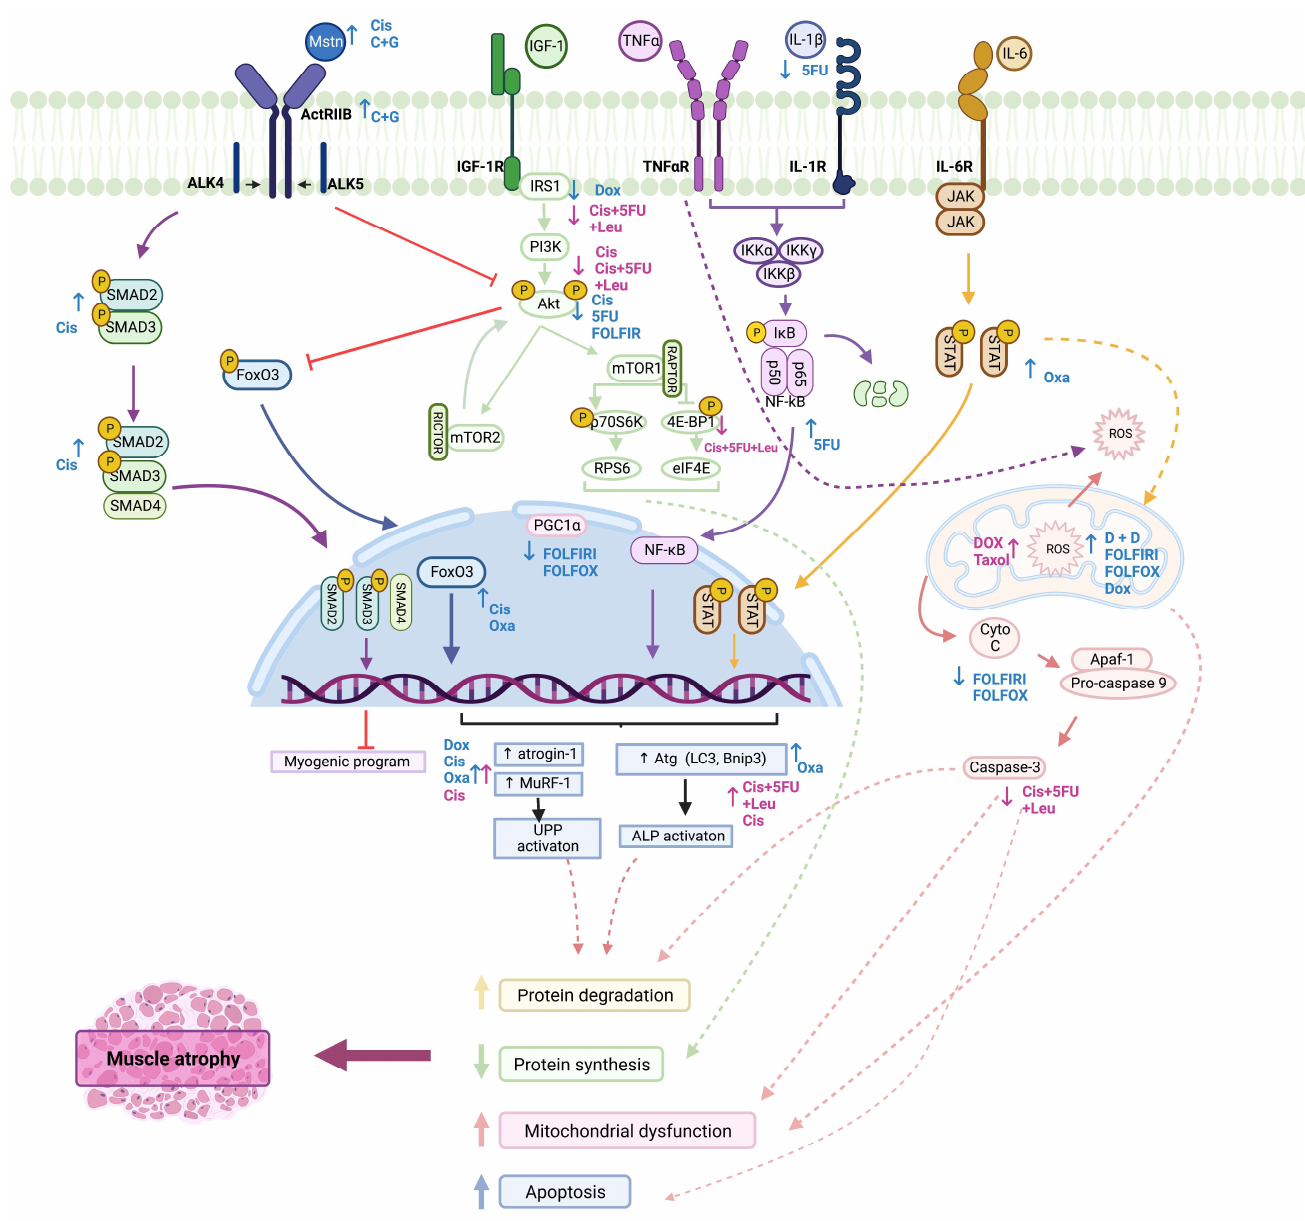
Figure 1. Signaling pathways modulated by chemotherapy in skeletal muscle. Doxorubicin decreases IRS1, NF- κ B, and PGC1 α expression, which consequently increases the expression of UPP (atrogin-1 and MuRF-1 ligases), and in mitochondria increases ROS generation. ROS levels also increased following doxorubicin plus dexamethasone treatment. Cisplatin increases phosphorylation of SMAD2, Mstn, and FOXO3 and induces atrogin-1 and MuRF-1 mRNA expression, thereby reducing Akt levels. When combined with gemcitabine, besides up-regulating atrogin-1, MuRF-1, Mstn, and FOXO3, cisplatin also stimulates ActRIIB. Oxaliplatin enhances STAT phosphorylation and activates both UPP and APL by increasing the expression of atrogin-1, MuRF-1, and Atg genes such as LC3 and BNIP3. 5-fluorouracil diminishes Akt levels and increases both p38 phosphorylation and NF- κ B levels. FOLFIRI and FOLFOX act similarly, both decreasing PGC1- α protein levels and increasing ROS levels; however, FOLFIRI also reduces Akt levels. Legend: Cis: cisplatin; Dox: doxorubicin; C+G: cisplatin plus gemcitabine; Oxa: oxaliplatin; D+D: doxorubicin plus dexamethasone; Cis+5FU+Leu: cisplatin plus 5-fluorouracil plus leucovorin. Blue: modulation of animal studies; pink: modulation of in vitro studies. Created with BioRender.com (accessed on 16 February